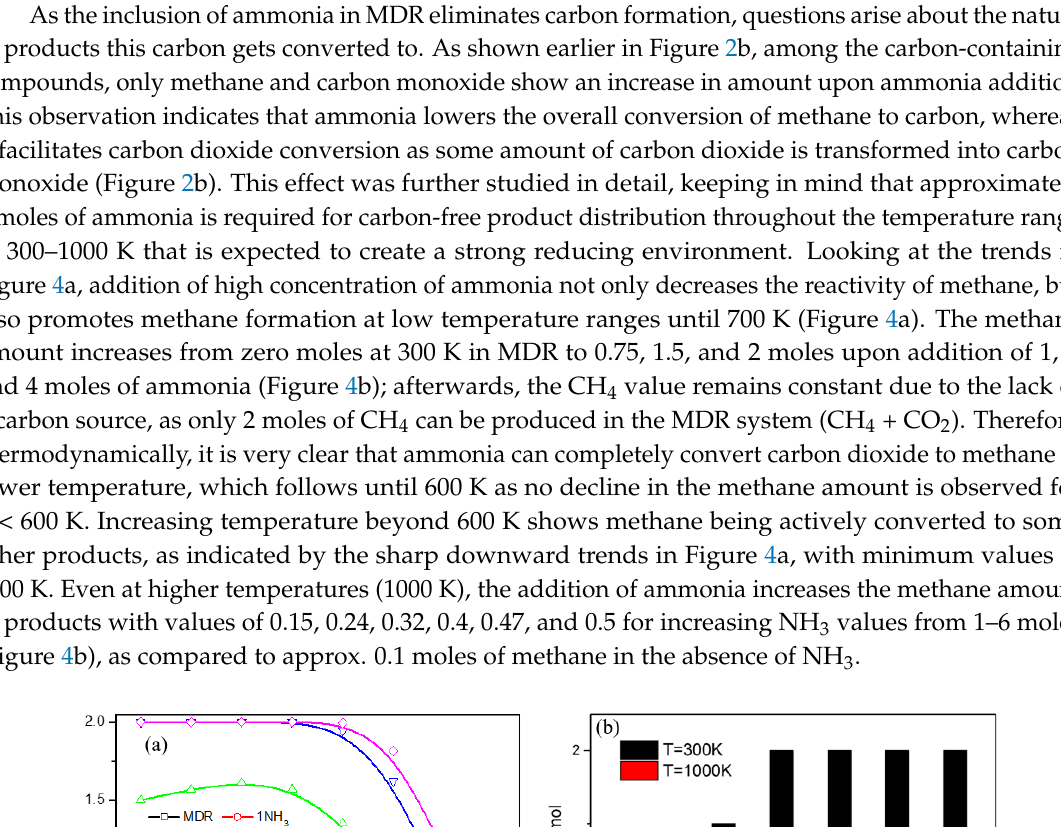
Figure 3. Effect of ammonia content on carbon formation in methane dry reforming; ( a ) at temperature 300–1000 K, ( b ) at temperature = 900 K.